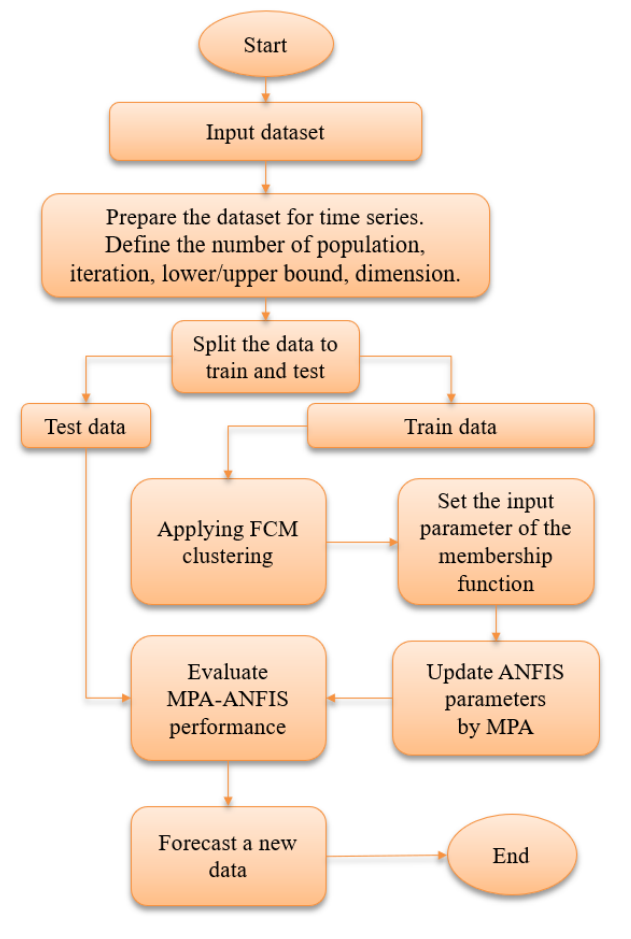
Figure 2. The flowchart of the proposed MPA-ANFIS algorithm. FCM, the Fuzzy